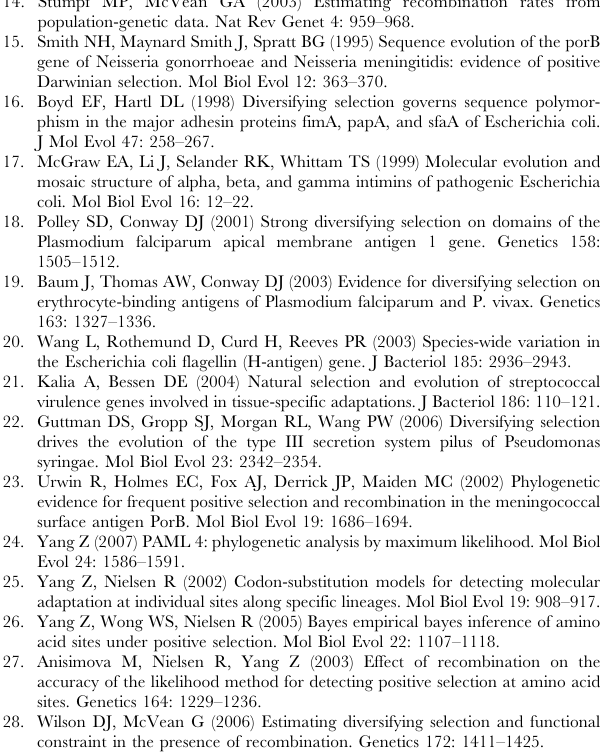
Figure S2 Phylogenetic Trees of the rlrA islet genes. Here we show the Neighbor Joining phylogenetic trees of rrgA , rrgB , rrgC , srtB , srtC , srtD (left to right, top to bottom). Due to the high level of sequence conservation, the tree for the rlrA transcriptional regulator is not shown. The background colors of the strains names show their clonal complex determined by eBURST. Since rrgB is the most variable protein, the strains are classified into